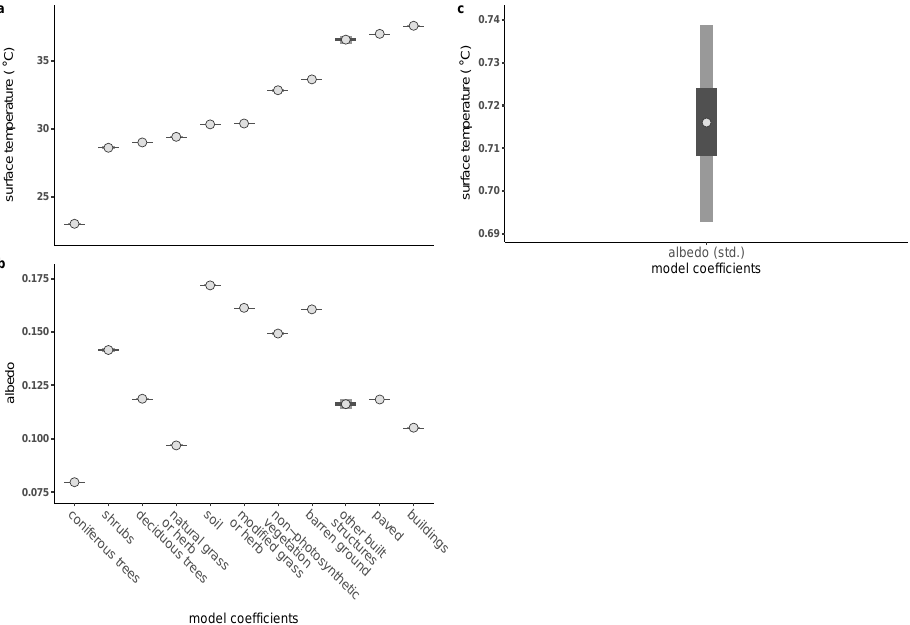
Figure 4. Secondary model results showing 95% credible intervals (outer) and 50% credible intervals (inner) for the ( a ) model of the effects of land cover classes on surface temperature, ( b ) model of the effects of land cover classes on albedo, and ( c ) model of the effects of albedo on surface temperature. See Tables A2–A4 for coefficient